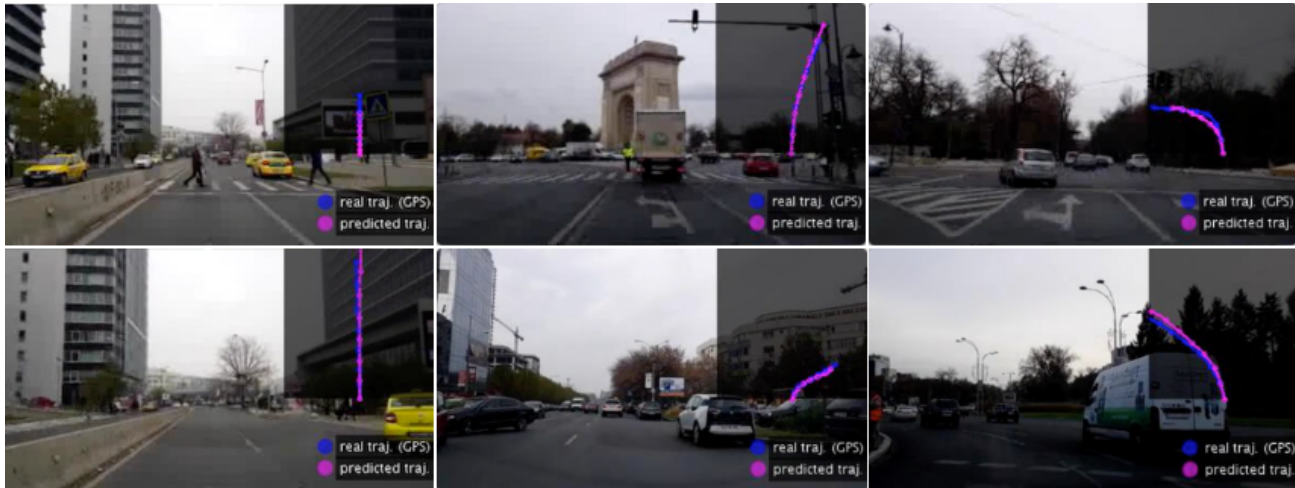
Figure 7. The trajectory predicted by the model in various traffic situations: stopping before a crosswalk (top left ), accelerating when the road is clear (bottom left ), before entering a roundabout (top middle ), beginning to turn right (bottom middle ), just before turning left (top right ) and keeping left steer in a roundabout (bottom right ). Notice how the trajectory, as a function of time also provides speed and acceleration information, not just spatial directions along a path. More specifically, the length of the trajectory indicates distance travelled per time. Thus, the spacing between the predicted locations in the next seven seconds are directly proportional to speed at those moments in time. The more distant the points, the faster the vehicle moves. Also, the variations in such spacing is directly related to acceleration, as the first derivative of speed with respect to